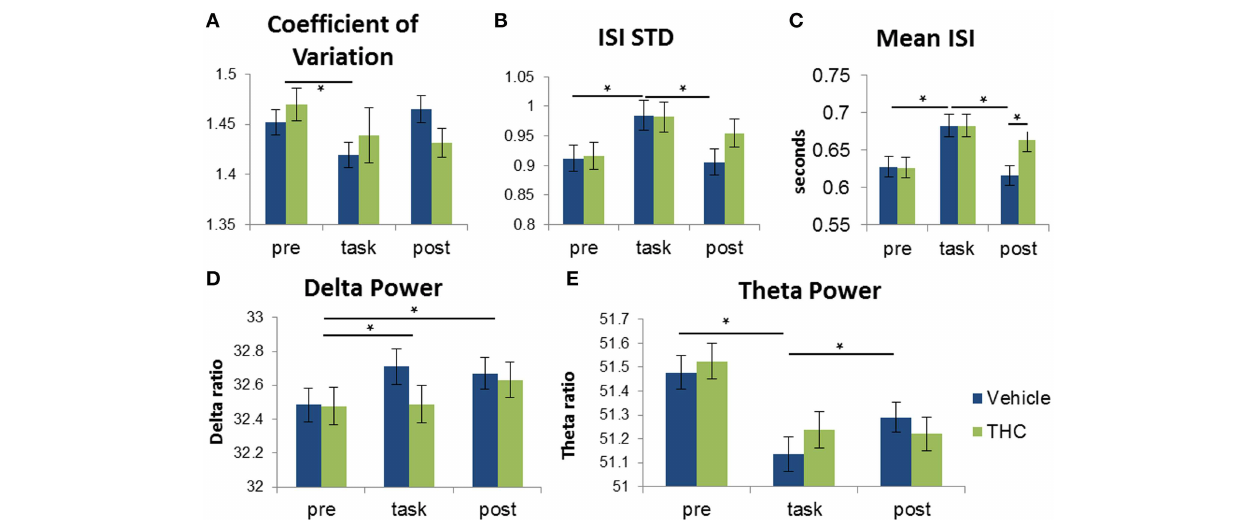
FIGURE 8 | Distinction between recording phases and drug conditions using frequency spectra and spike train variability measures. Each bar was obtained by averaging values from individual spike trains within specified recording phase and drug treatment combinations ( n = 771 –1004 neurons per group). Vehicle (blue) or THC (green) was given after pre-task recording, so measures obtained during the pre-task recording should be the same for drug conditions. Statistical significance is designated by * indicating p < 0 . 0083 (Bonferoni correction). Error bars represent S.E.M. (A) Repeated measures ANOVA using coefficient of variation (CV) as the dependent variable yielded a significant main effect of recording phase but no significant interaction between drug condition and recording phase. CV was greater during pre-task recordings compared to recordings during the DNMS task. (B) A significant interaction between recording phase and drug condition revealed that ISI standard deviation is greater during the task compared to pre- and post-task recordings. (C) A significant interaction between recording phase and drug condition revealed that ISIs recorded under vehicle administration were larger during the task vs. pre- and post-task conditions. THC increased mean ISI only during the post-task recording but had no effect during the task. (D) A significant main effect of recording phase was found when assessing delta power: Delta power was larger during task and post-task vs. pre-task sessions. (E) Theta power of hippocampal neurons was higher during the task-independent (pre- and post-task) resting phases compared to during DNMS task